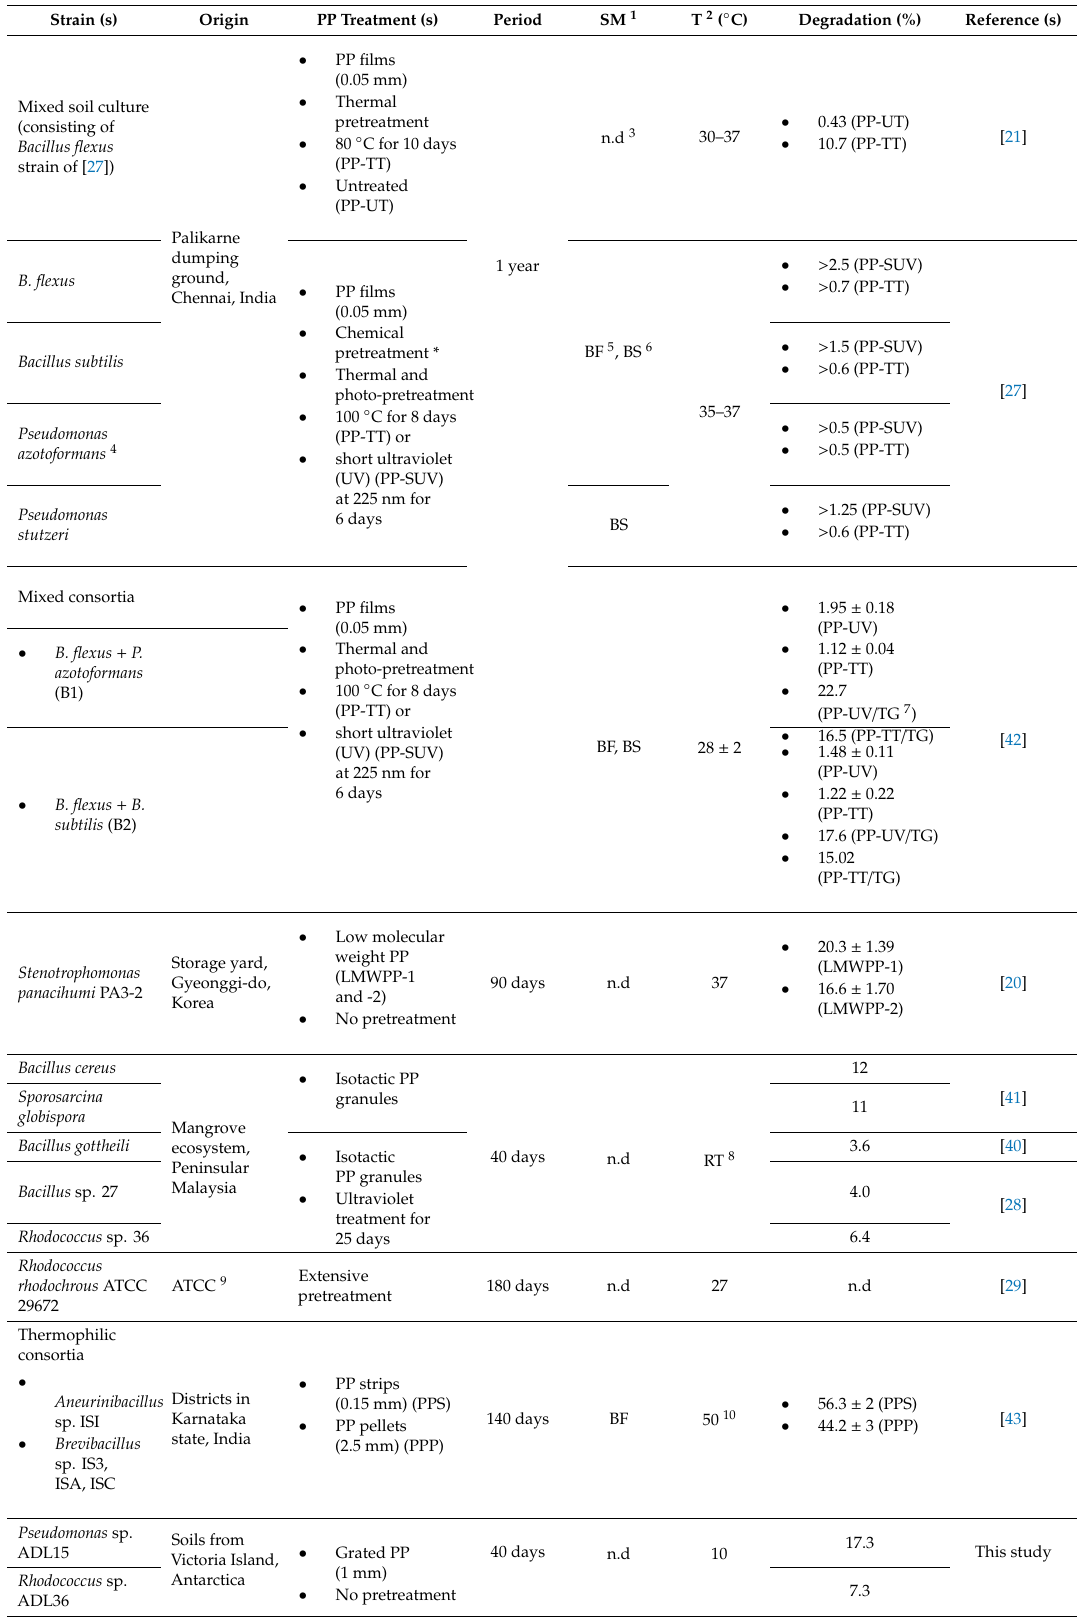
Table 2. The polypropylene-degrading bacterial strains and